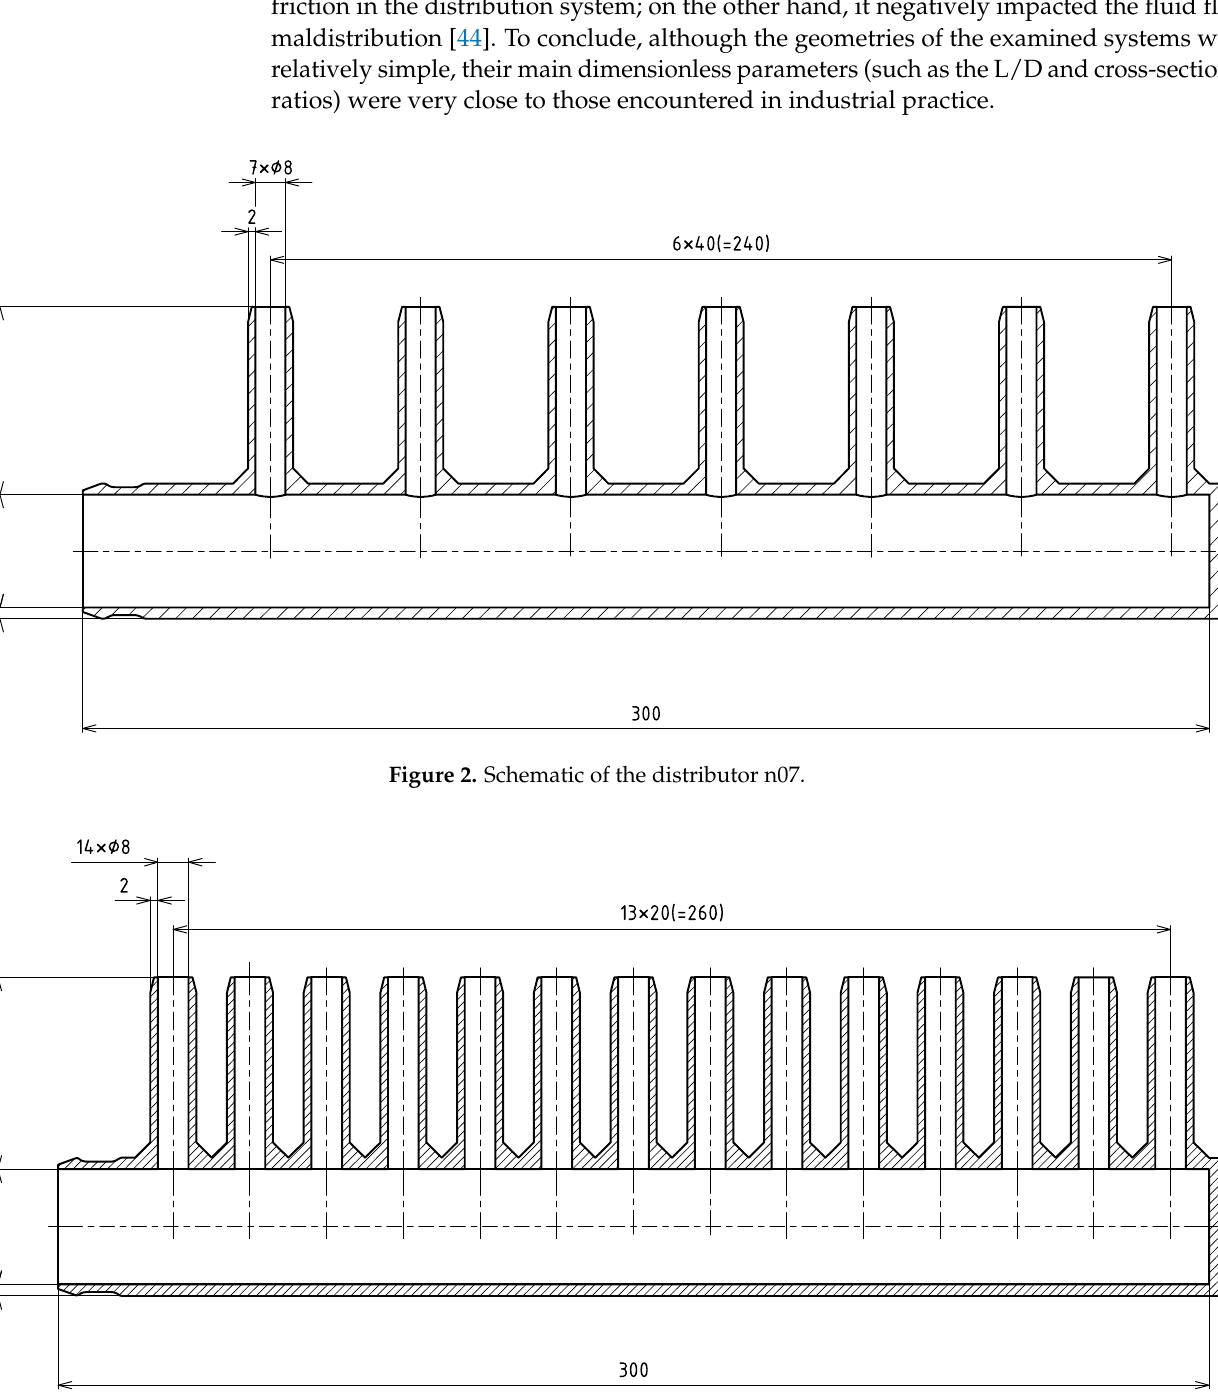
Figure 3. Schematic of the distributor n14.